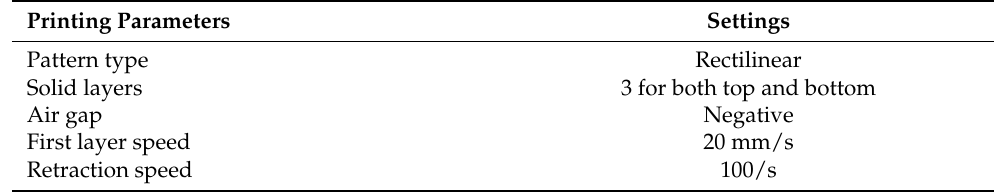
Table 2. Printing parameters that are kept